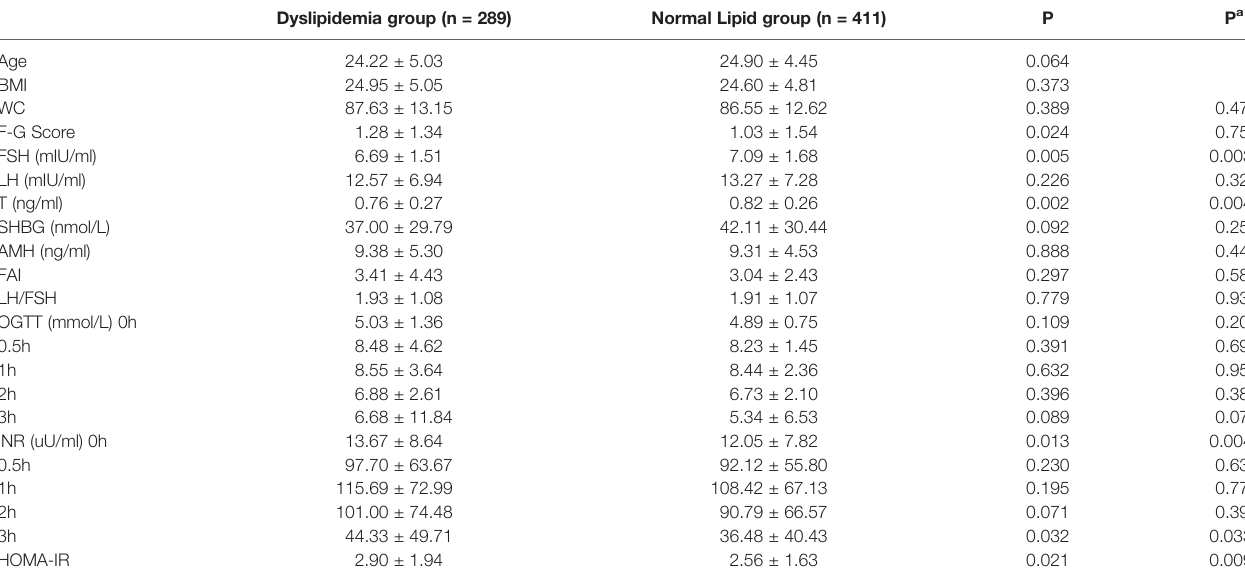
TABLE 2 | Clinical and biochemical characteristics of PCOS women according to blood lipid